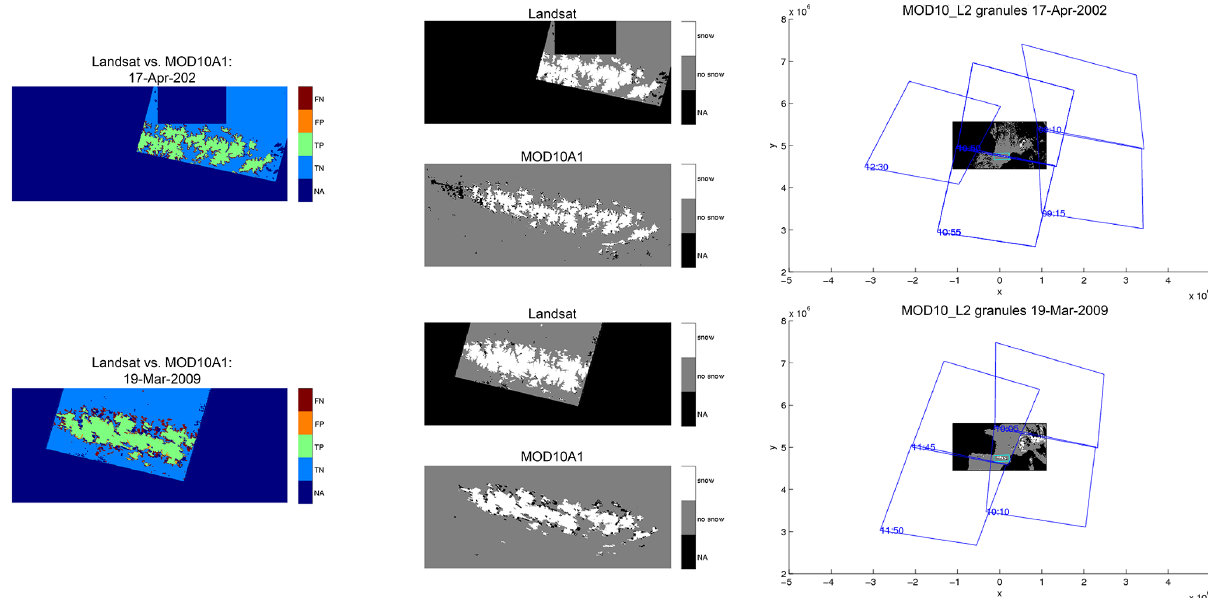
Figure 9. Comparison between MOD10A1 and Landsat for two dates. Left column: MOD10A1 vs. Landsat classification (TP: true positive, FP: false positive, TN: true negative, FP: false positive). MOD10A1 false negative areas are mainly located along the snow cover edges. Mid- dle column: Landsat and MOD10A1 classifications used for the comparison. Right column: location of the input swath granules (MOD10_L2 product) used to generate the MOD10A1 tiles (sinusoidal map projection). The MOD10A1 snow mask is distorted on 19 March 2009 because it was constructed from the border areas of two input granules where the bow-tie effect is most